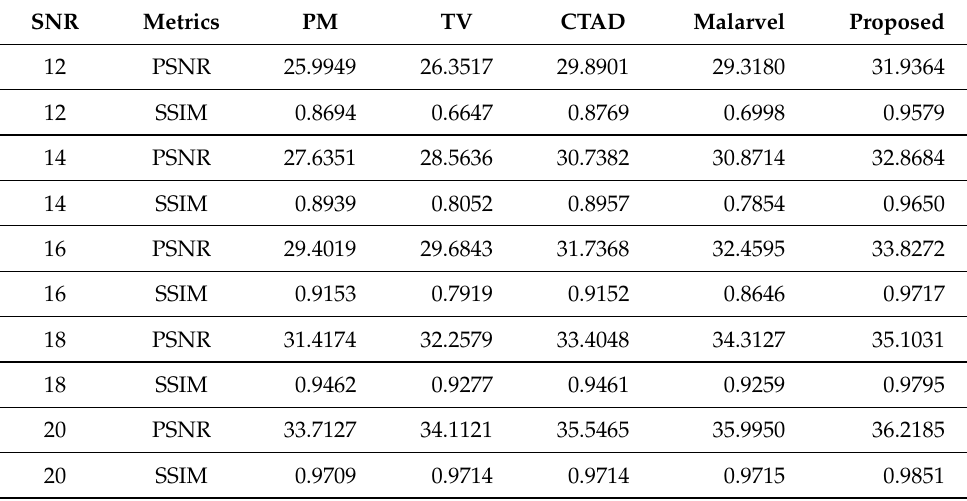
Table 2. Results evaluation on artificial image